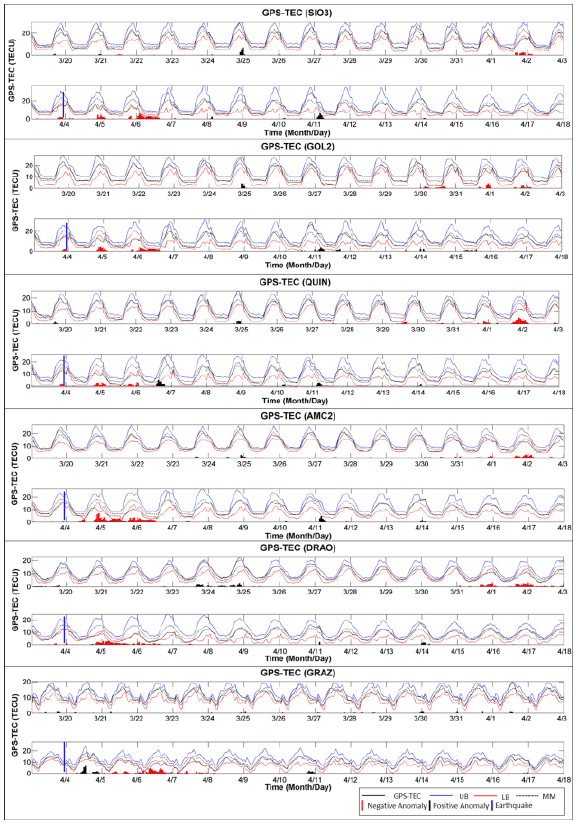
Figure 1. Selected earthquakes and locations around the world. All maps, graphics, calculations and some statistical procedures were performed by MATLAB® scripts. For these earthquakes, the radius of the earthquake preparation zones (EPZ) were the radius of the EPZ (km) and M is the magnitude of the earthquake on the moment magnitude scale (Dobrovolsky et al. 1979). The radius of the EPZs for the earthquakes were calculated. IGS stations in the vicinity of the earthquake zone were obtained. According to Oyama et al. 2008, the disturbed region extends across a wide range of latitudes and longitudes such as 60° in the East–West direction and 40° in the North– South direction for large earthquakes of magnitude (M > 6).